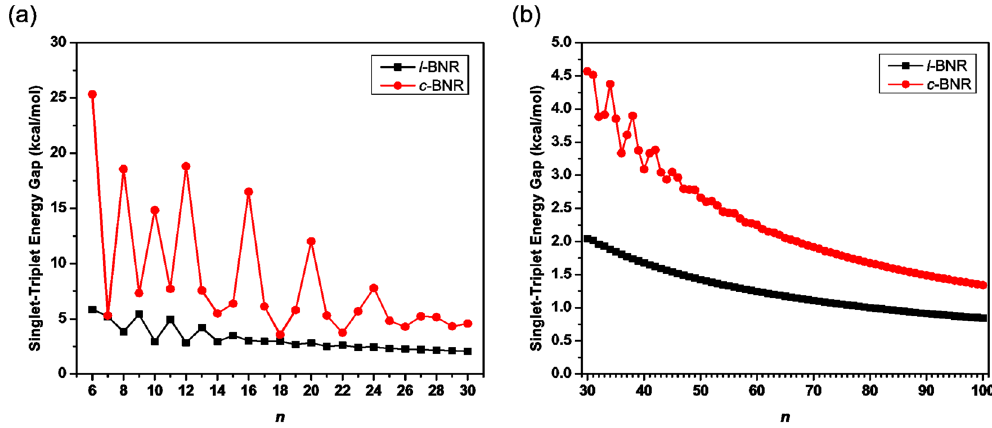
Figure 2. Singlet-triplet energy gap of l -BNR[2, n ]/ c -BNR[2, n ] (( a ) n = 6–30 and ( b ) n = 30–100), obtained from spin-unrestricted